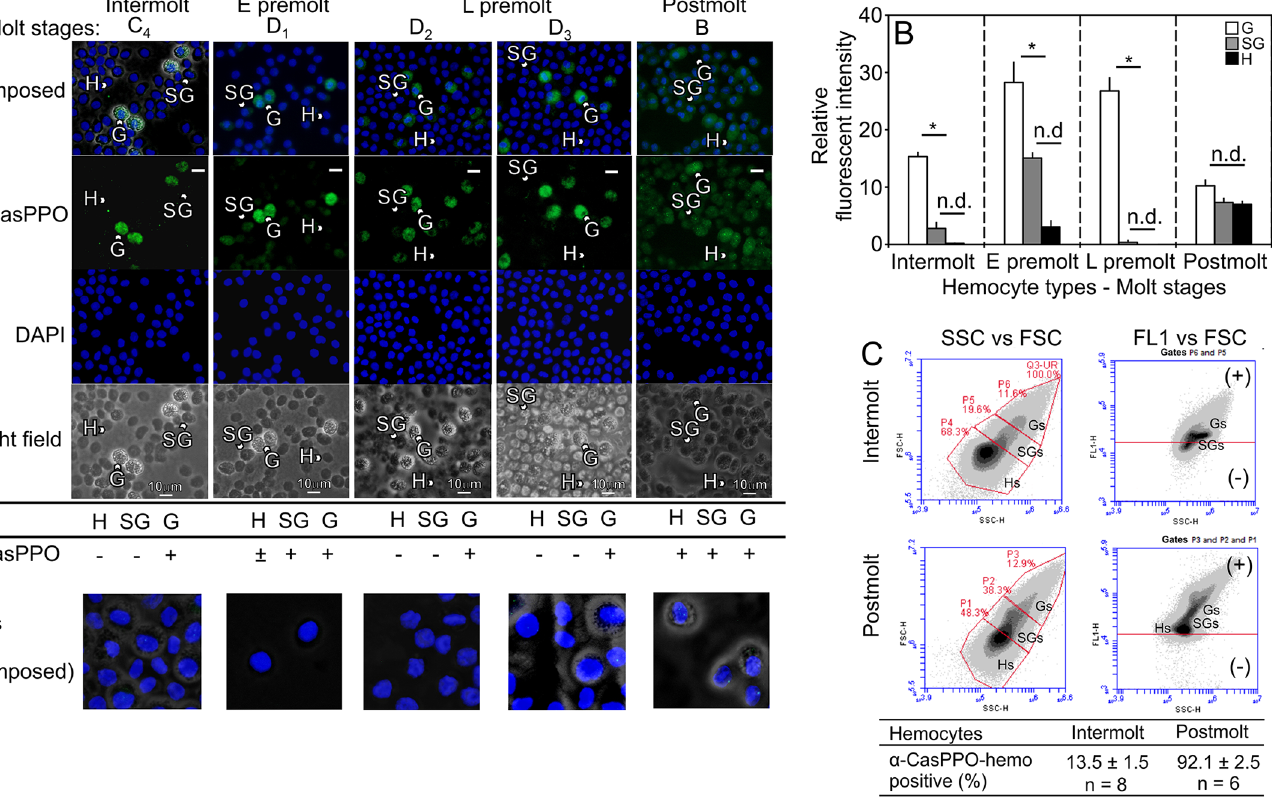
Fig 5. Identification of CasPPO-hemo in hemocytes during the molt cycle of C . sapidus . Immunostaining of hemocytes at different molt stages using a specific α -CasPPO-hemo. Granulocytes contain PPO during all the molt stages, while semigranulocytes and hyaline cells show a PPO protein expression which is molt-stage dependent. Signals: + PPO and – PPO. (A) ICC (n = 5 – 6) and (B) fluorescent intensity of the positive signal of α -CasPPO-hemo staining using ImageJ. (C) Immunostaining of CasPPO-hemo by flow cytometry analysis: At intermolt stage, ~14% of hemocytes are PPO positive, while at postmolt, the PPO positive hemocytes are over 90% (n = 5 – 8). Bar scale = 10 μ m. G = granulocytes; SG = semigranulocytes; H = hyaline